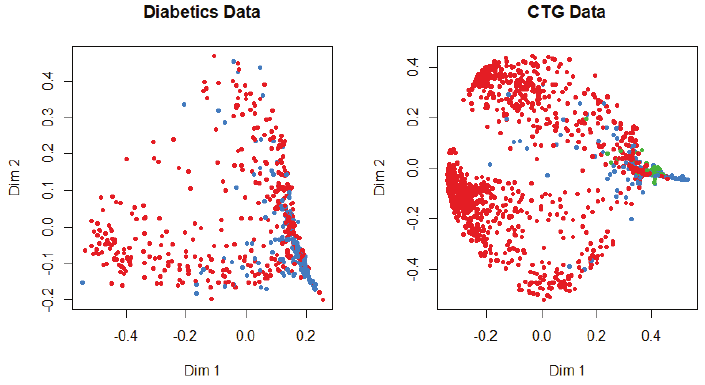
Figure 3. Multi-dimensional scaling plot for both